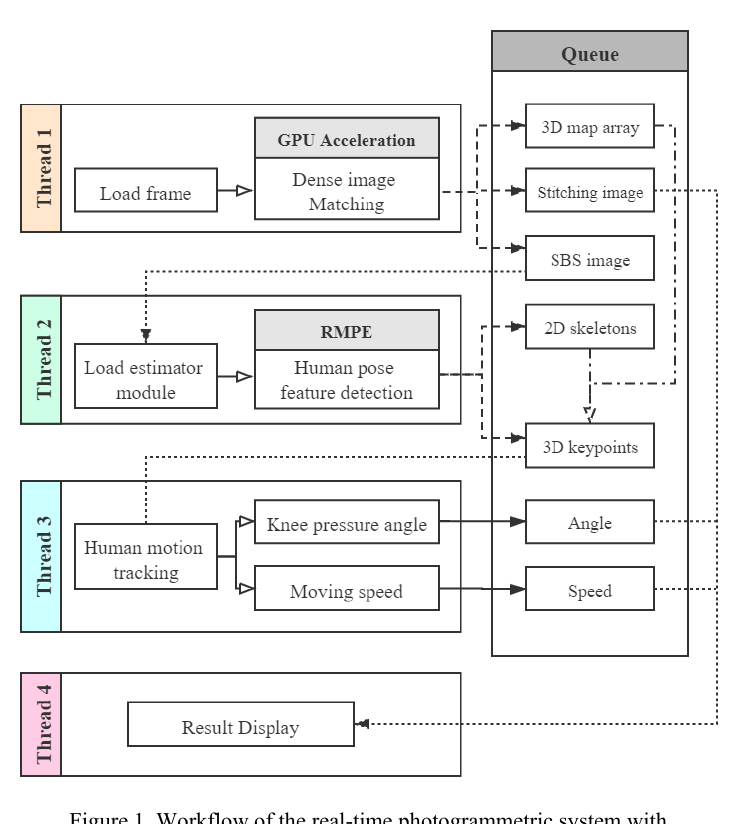
Figure 1. Workflow of the real-time photogrammetric system with multithreading and graphics-processing unit (GPU)